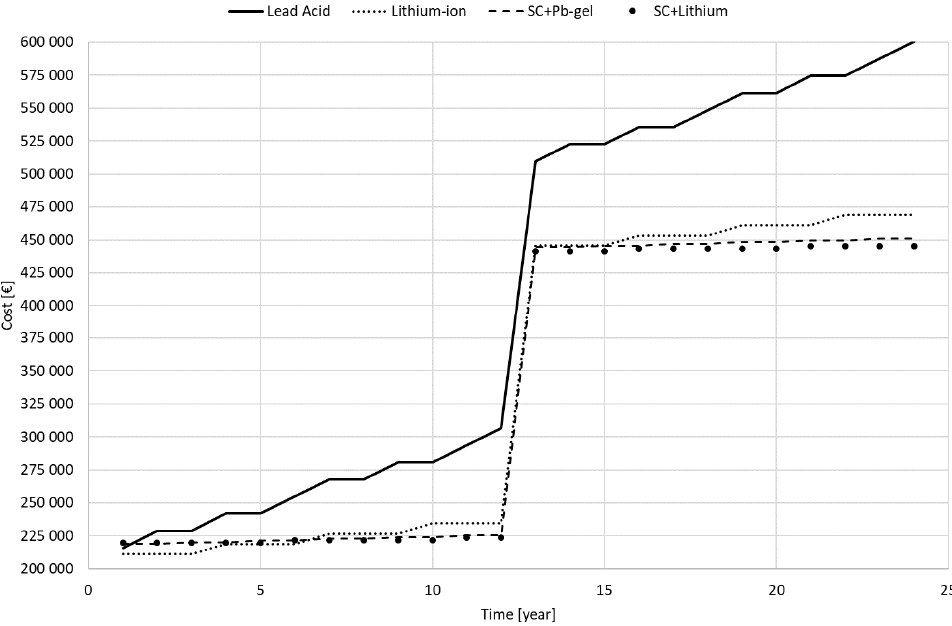
Figure 13. Economic comparison.